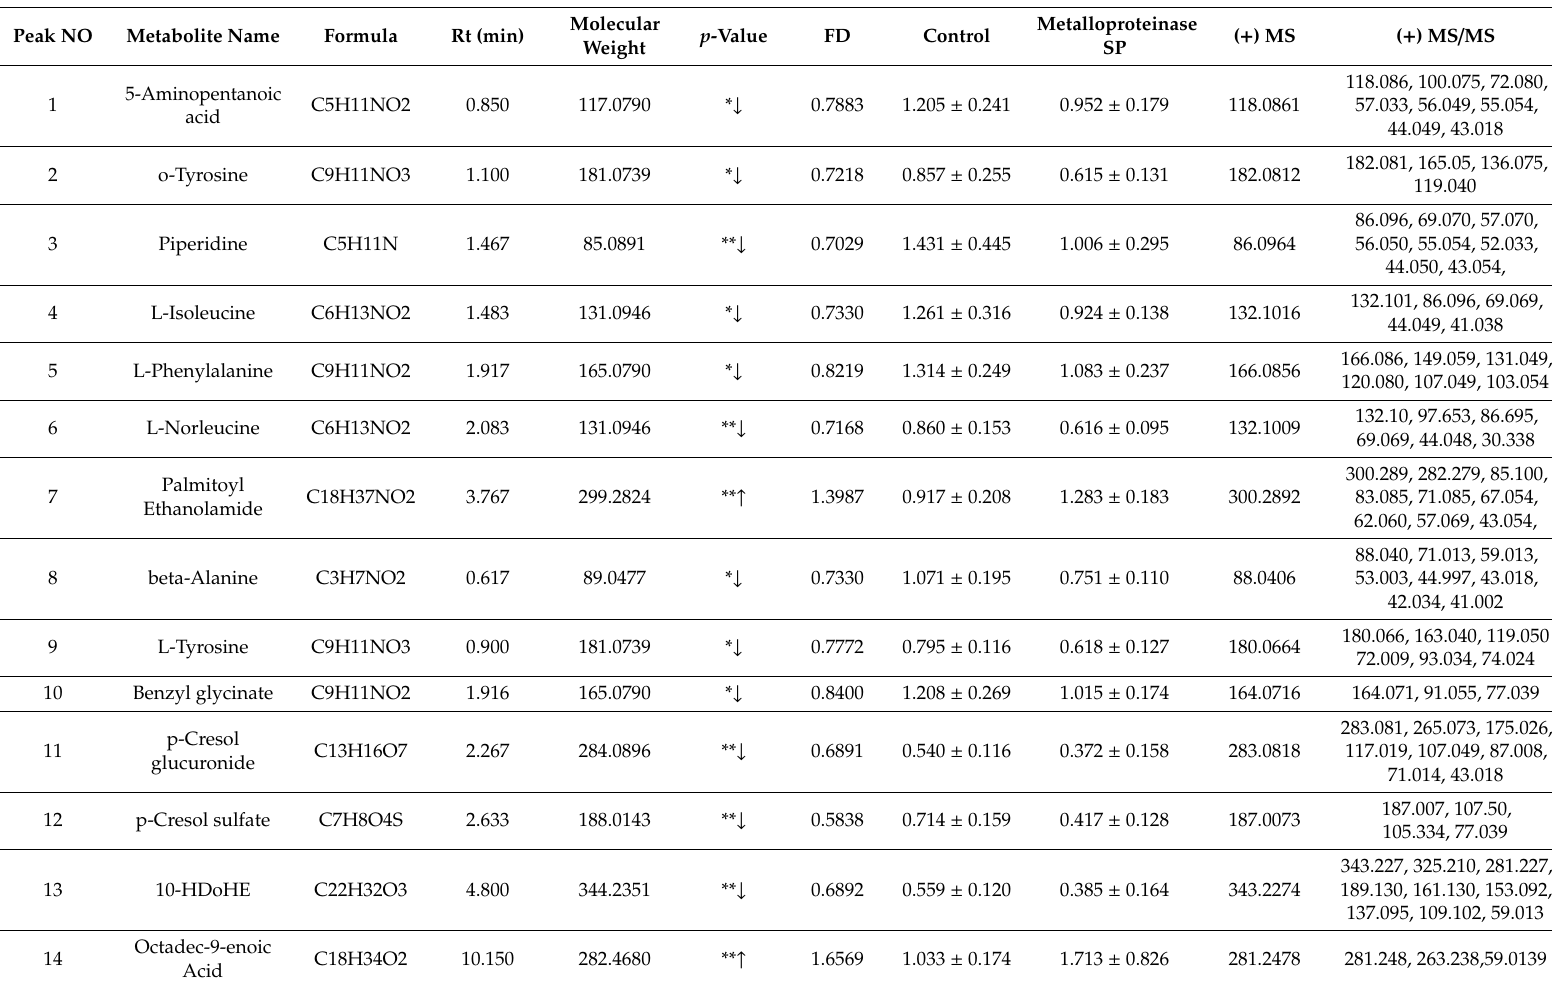
Table 4. The significantly changed metabolites in mice plasma after treatment with metalloproteinase